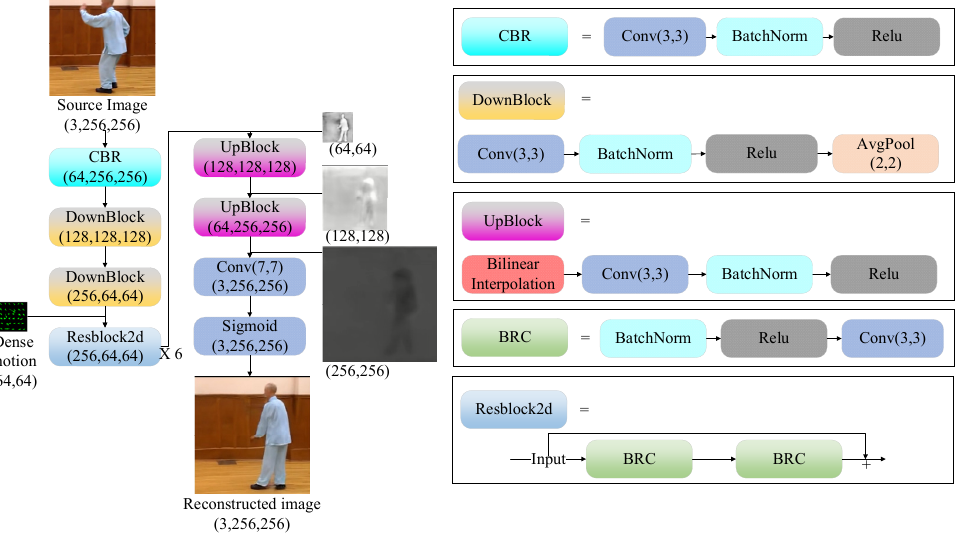
Figure 9. Diagram of the generator.